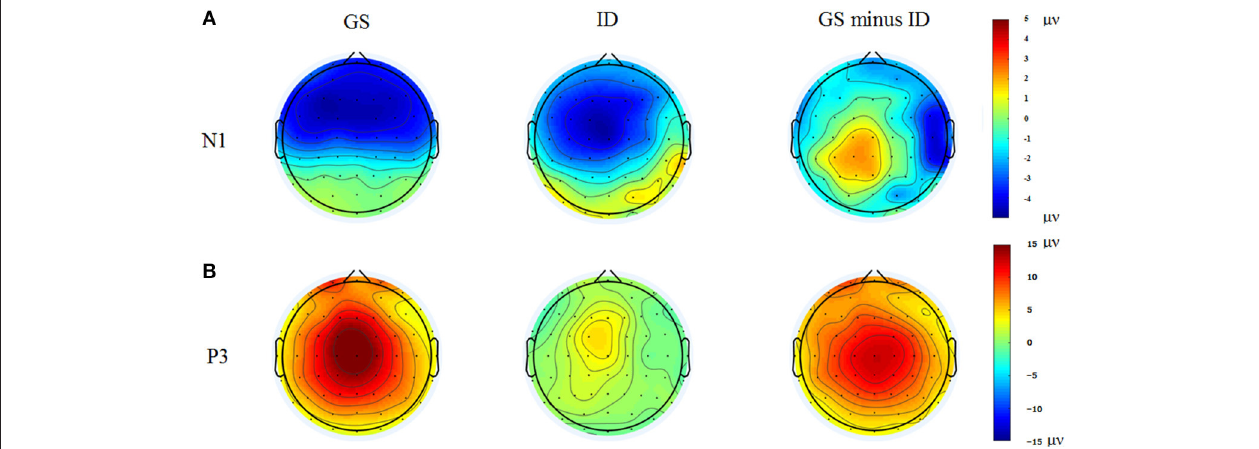
FIGURE 4 | Topographic maps of the N1 (80–180ms, A ) and P3 (230–400ms, B ) components time-locked to the auditory stop-signal in the successful stop trials. Left: Topographic maps of each ERP component for the group of good sleepers (GS). Middle: Topographic maps of each ERP component for the group of insomnia disorders (ID). Right: Topographic maps of each ERP component for the GS minus ID.